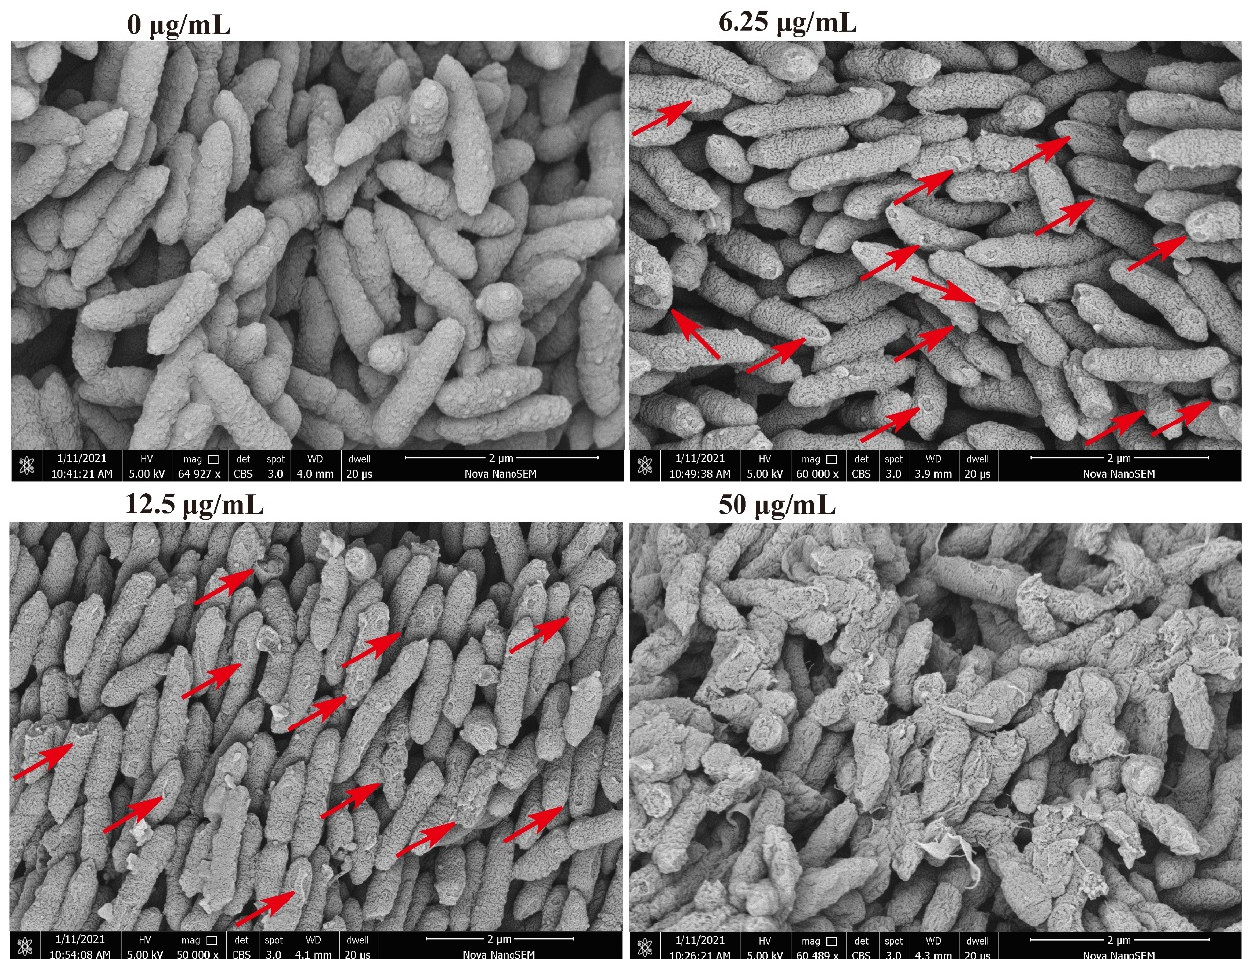
Figure 4 . Changes of morphological structure of Xac under the action of compound 1. The test con- centrations were 50, 12.5, and 6.25 μ g/mL. Red arrows point to areas with obvious structural dam- age.